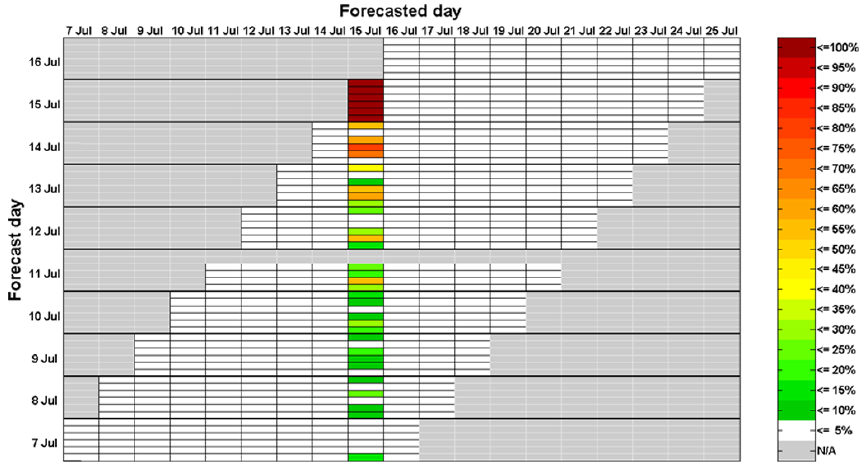
Fig. 5. The warning table for the studied flood event. The six horizontal bars from bottom to top represent the five centres (CMC, CMA, ECWMF, UKMO, NCEP), and the ensemble of the five forecast